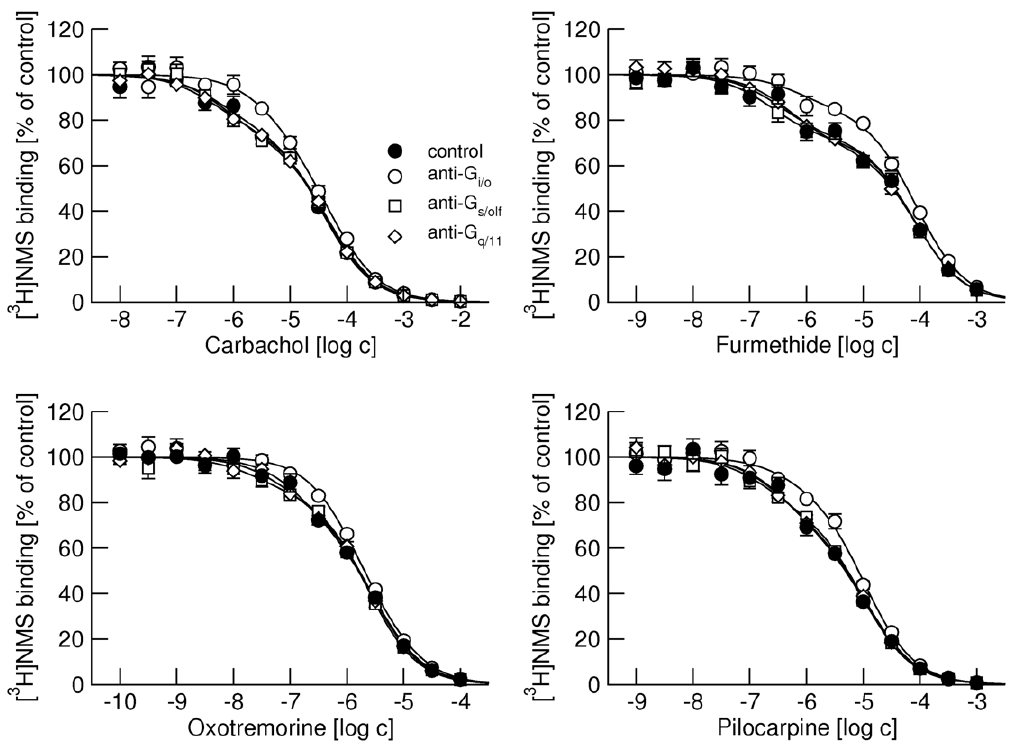
Figure 8. Effects of anti-G-protein antibodies on competition between agonists and [ 3 H]NMS binding at M 2 receptors after suppression of G i/o G-proteins expression. Binding of 1 nM [ 3 H]NMS to membranes from CHO cells expressing M 2 receptors after suppression of expression of G i/o G-proteins by siRNA was determined in the presence of increasing concentrations (abscissa, log M) of the agonists carbachol (upper left), furmethide (upper right), oxotremorine (lower left), and pilocarpine (lower right). Binding is expressed as per cent of control binding in the absence of agonist. Filled circles, control binding in the absence of antibodies. Open symbols, binding in the presence of anti-G i/o (circles), anti-G s/olf (squares) and anti-G q/11 (diamonds) antibodies. Data are means 6 S.E.M of values from 3 experiments performed in quadruplicates. Curves were fitted using equation 3 and results of fits are shown in Table 6.